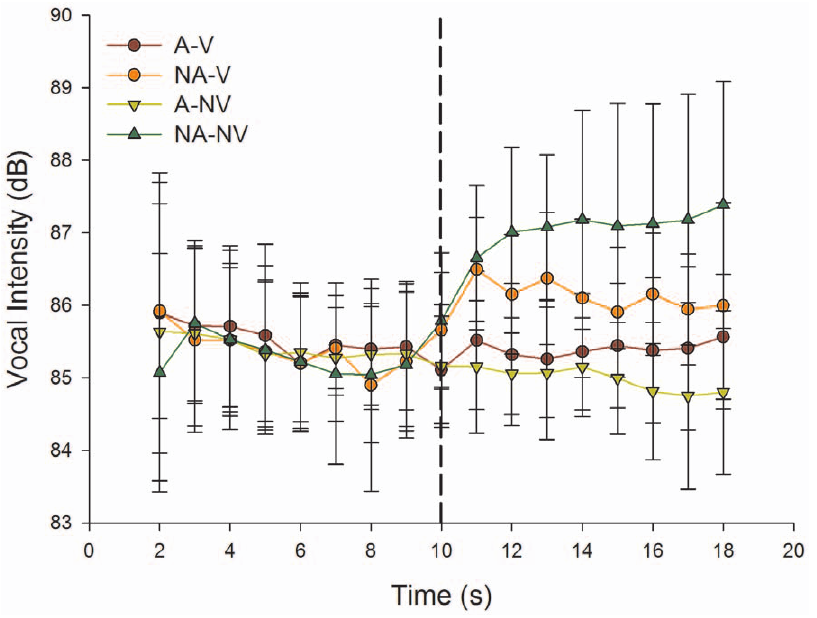
Figure 2. The vocal intensity time series for all conditions, grand averaged across participants. Error bars represent SD. The vertical dashed line represents the time at which auditory voice feedback, visual feedback of vocal intensity or both were removed.